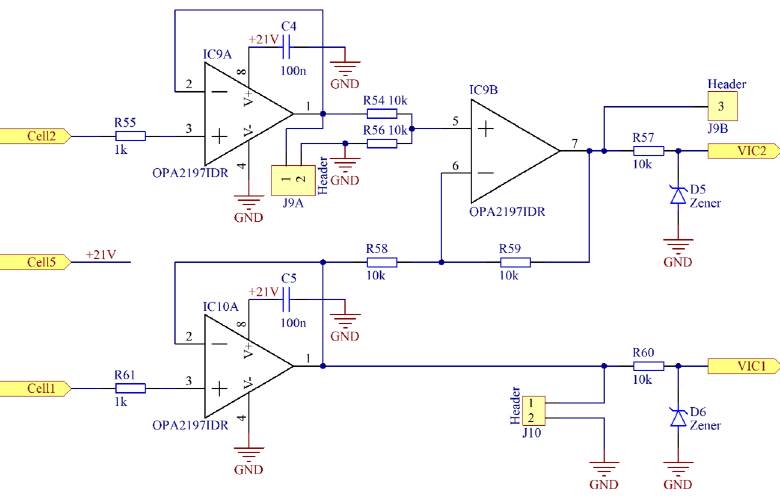
Figure 6. A part of the “Measuring” schematic sheet.